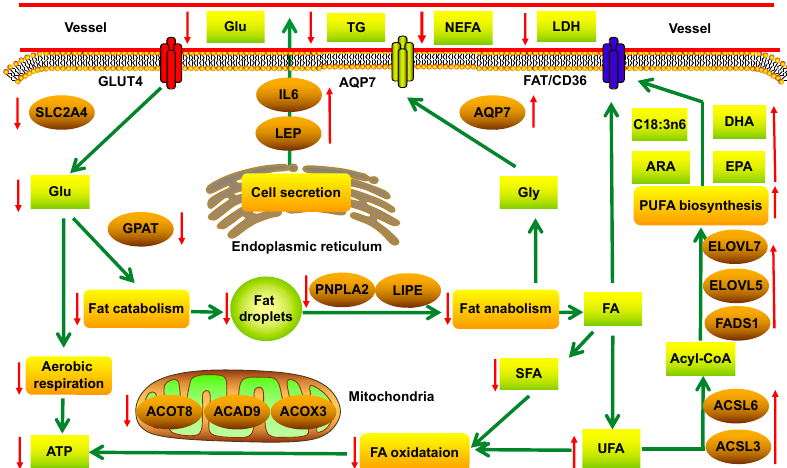
Figure 3. The fat metabolism in the subcutaneous fat of yaks under long-term energy stress (ES). ↑ : upregulation of gene expression or increased concentration of metabolite or enhanced metabolic pathway; ↓ : downregulation of gene expression or decreased concentration of metabolite or diminished metabolic pathway.